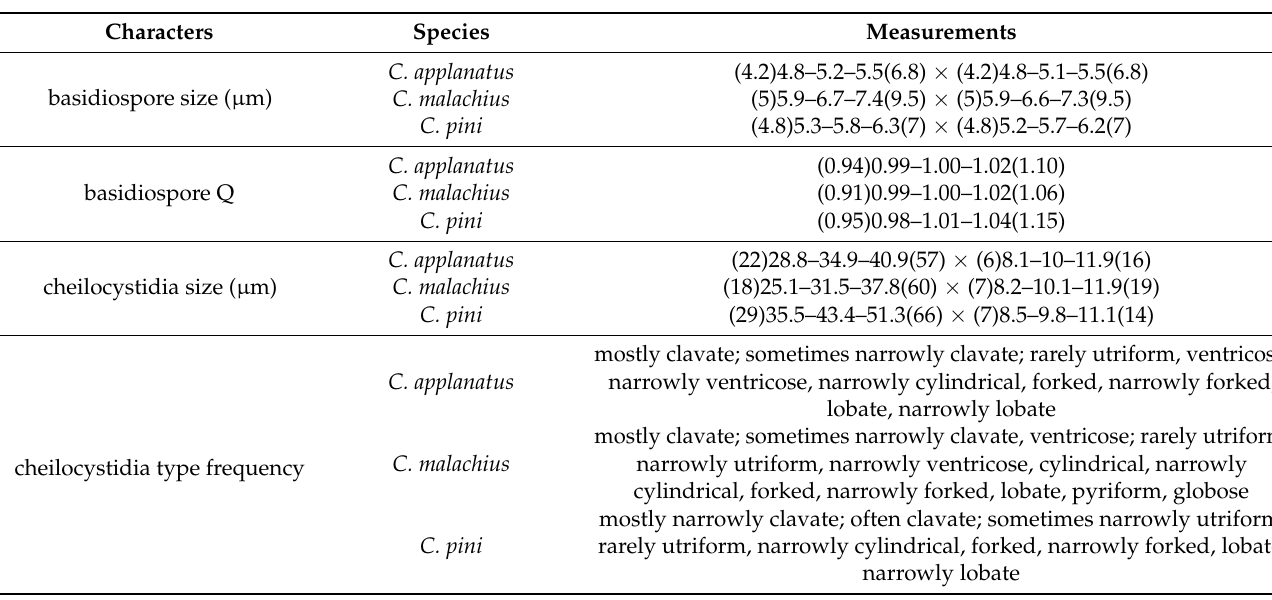
Table 1. Basidiospore and cheilocystidia characteristics measured on Crepidotus applanatus ( n = 300), C. malachius ( n = 360) and C. pini ( n = 90). The size of basidiospores and cheilocystidia, the length/width ratio of basidiospores (Q), and the frequency of occurrence of cheilocystidia types (mostly = 50.1–99%, often = 25.1–50%, sometimes = 5.1–25%, rarely = 0.1–5%) was calculated based on the sequenced specimens (Supplementary Tables S1–S4); n = total number of measurements (30 measurements per specimen); the measurements are presented as averages ± standard deviation, values in parenthesis = minimum and